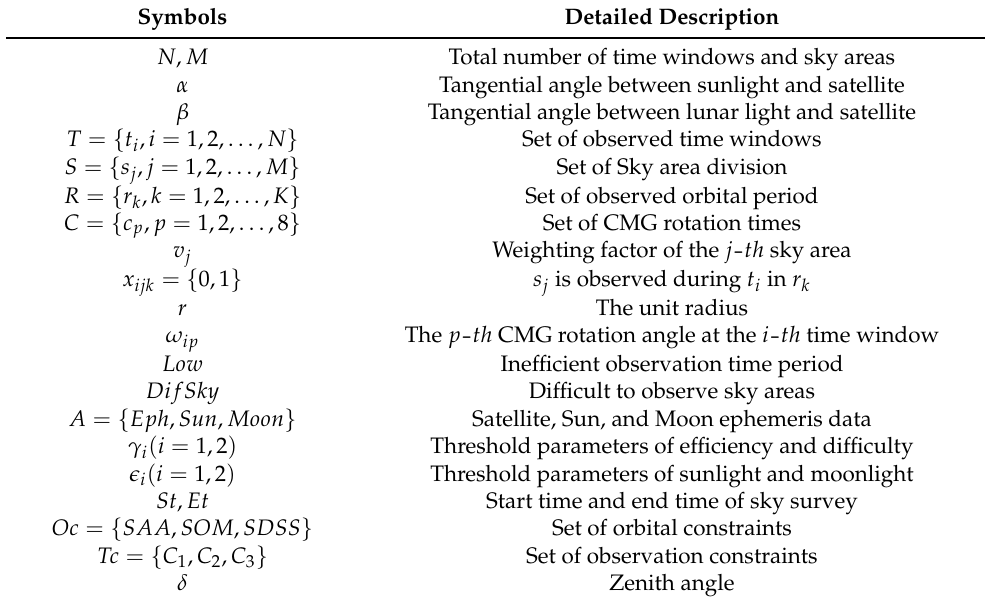
Table 3. Symbols used and specific